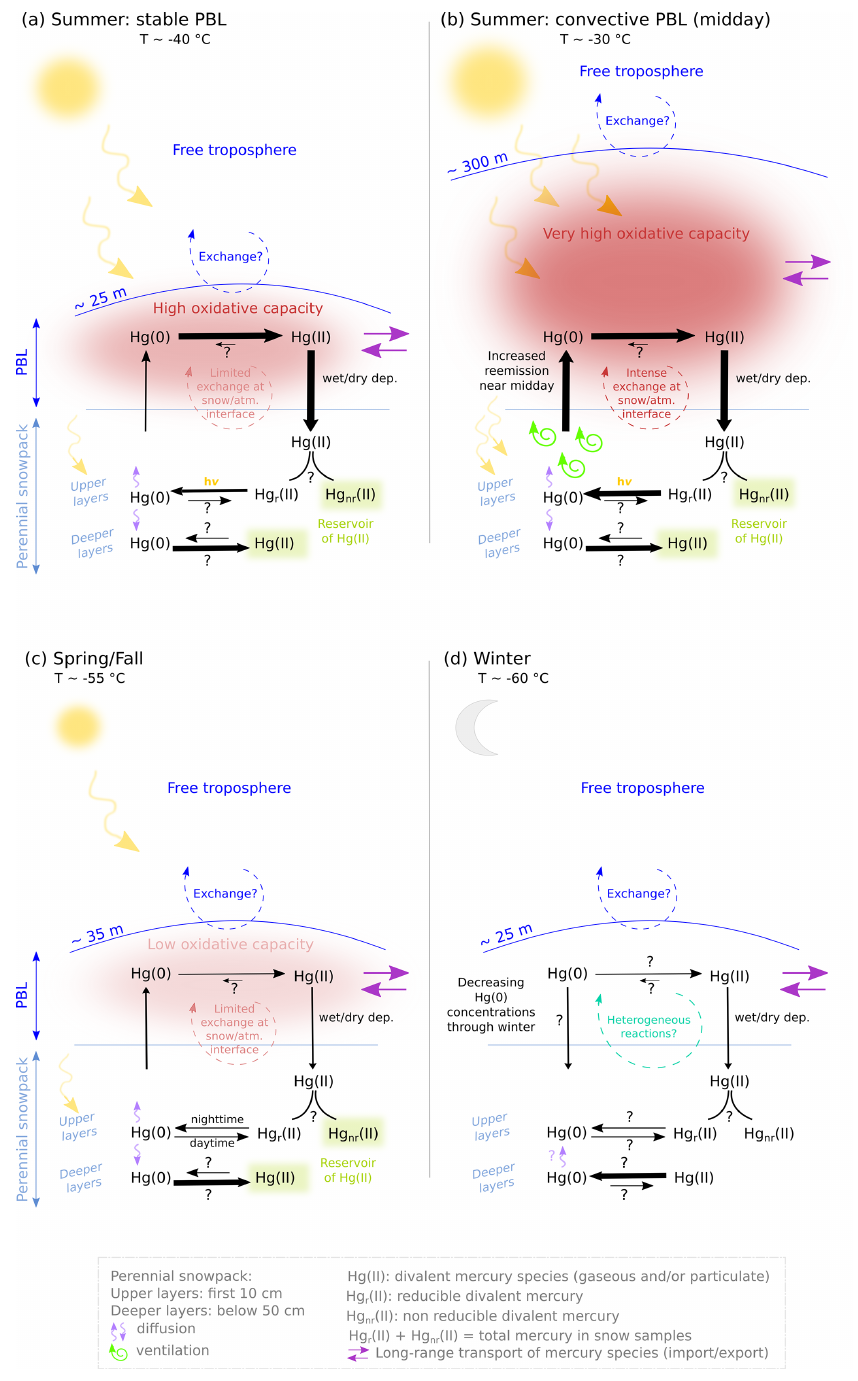
Figure 8. Schematic diagram illustrating the processes that govern the Hg(0) budget at Concordia Station (a) in summer under stable Planetary Boundary Layer (PBL) conditions, (b) in summer under convective PBL conditions, (c) in spring/fall, and (d) in winter. In summer, Hg(0) is intensely oxidized due to the high oxidative capacity of the boundary layer and a large amount of divalent mercury species deposit onto the snowpack. A fraction of deposited mercury can be reduced (the reducible pool, Hg r (II)) in the upper layers of the snowpack and subsequently re-emitted to the atmosphere as Hg(0). Hg(0) emission from the snowpack maximizes near midday likely due to increased ventilation as a response to daytime heating. Oxidation of Hg(0) dominates in the deeper layers of the snowpack likely leading to the formation of a Hg(II) reservoir. In spring/fall, the balance of reduction and oxidation processes within the upper layers of the snowpack differs from summertime: oxidation dominates during the day, reduction at night. In winter, Hg(0) is produced in the deeper layers of the snowpack likely as a result of the reduction of Hg(II) species accumulated during the sunlit period. Ambient Hg(0) concentrations exhibit a 20 to 30% decrease through winter possibly due to dry deposition of